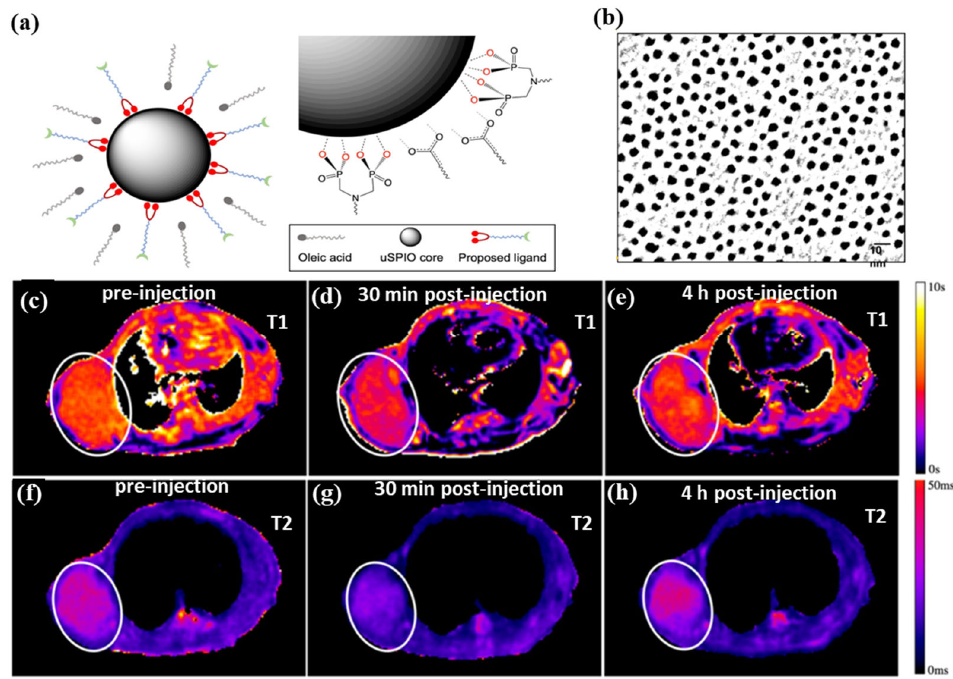
Figure 4. ( a ) Diagram illustrates the process of exchanging ligands and uSPIOs, ( b ) TEM image of uSPIOs, ( c – e ) T1 mapping, and ( f – h ) T2 mapping of the uSPIOs in the mouse at a different time interval. Reprinted from Ref. [130]. Copyright 2021 ACS.